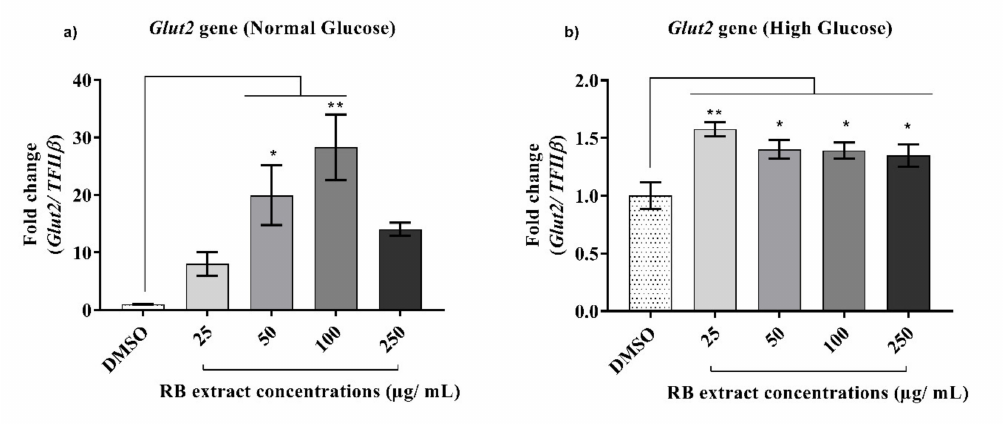
Figure 2. E ff ect of RB phenolic extracts on the expression of the Glut2 gene under normal and high glucose conditions in INS-1E cells. ( a ) Normal glucose conditions, ( b ) High glucose conditions ( n = 5). The level of significance is indicated by the asterisks, whereby * p < 0.05, ** p < 0.01. Data are presented as Mean ± SD. Dimethyl sulfoxide, DMSO; Insulin-secreting rat insulinoma cell, INS-1E; Glucose transporter 2, Glut2 ; Rice bran, RB.